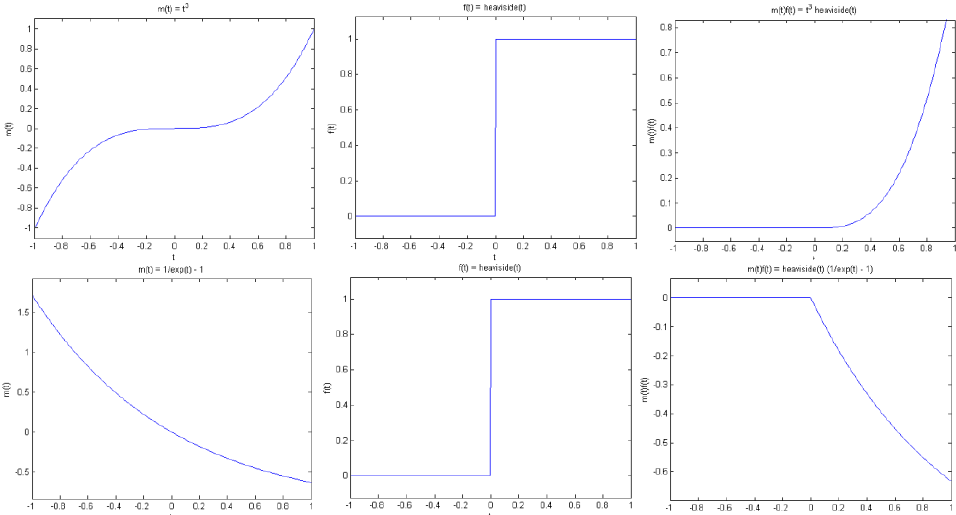
Figure 5. ( Left )—Modulation function m ( t ); ( Middle )—Signal f ( t ); ( Right )—Modulated signal m ( t ) f ( t ).